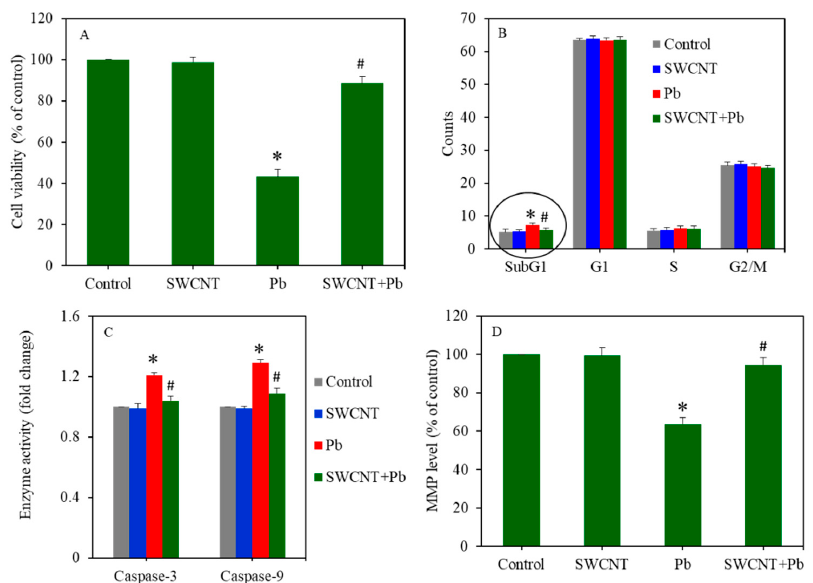
Figure 3. Cytotoxicity endpoints in A549 cells after exposure to either SWCNTs (10 µ g / mL) or Pb (50 µ g / mL), or a combination of both (SWCNTs + Pb) for 24 h. ( A ) Cell viability, ( B ) cell cycle, ( C ) caspase-3 and -9 enzymes activity, and ( D ) MMP level. Data provided as the mean ± SD of three identical experiments made in three replicates. * Significantly di ff erent from the control group ( p < 0.05). # Attenuating e ff ects of SWCNTs against Pb-induced cytotoxicity. SWCNTs: Single-walled carbon